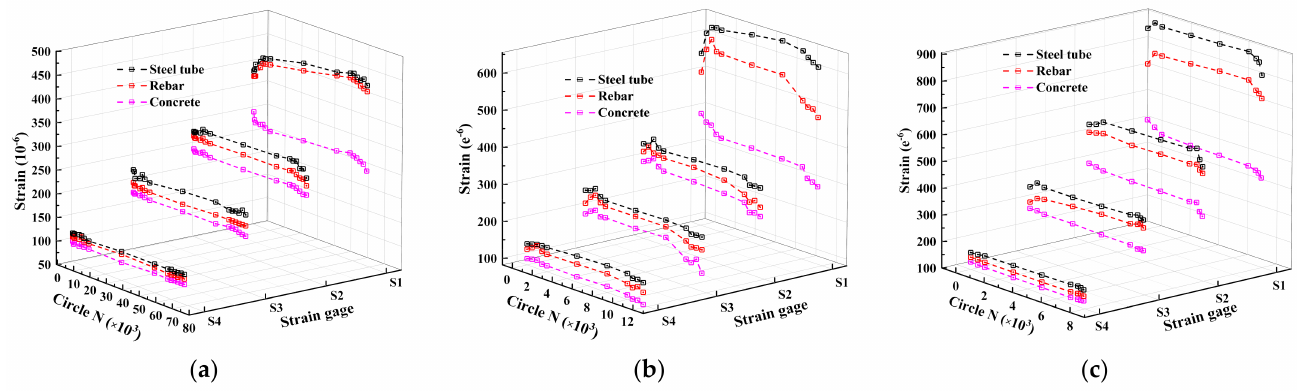
Figure 7. The axial strain curves of steel tube, the main steel bars and concrete core: ( a ) SPA; ( b ) SPB; ( c )